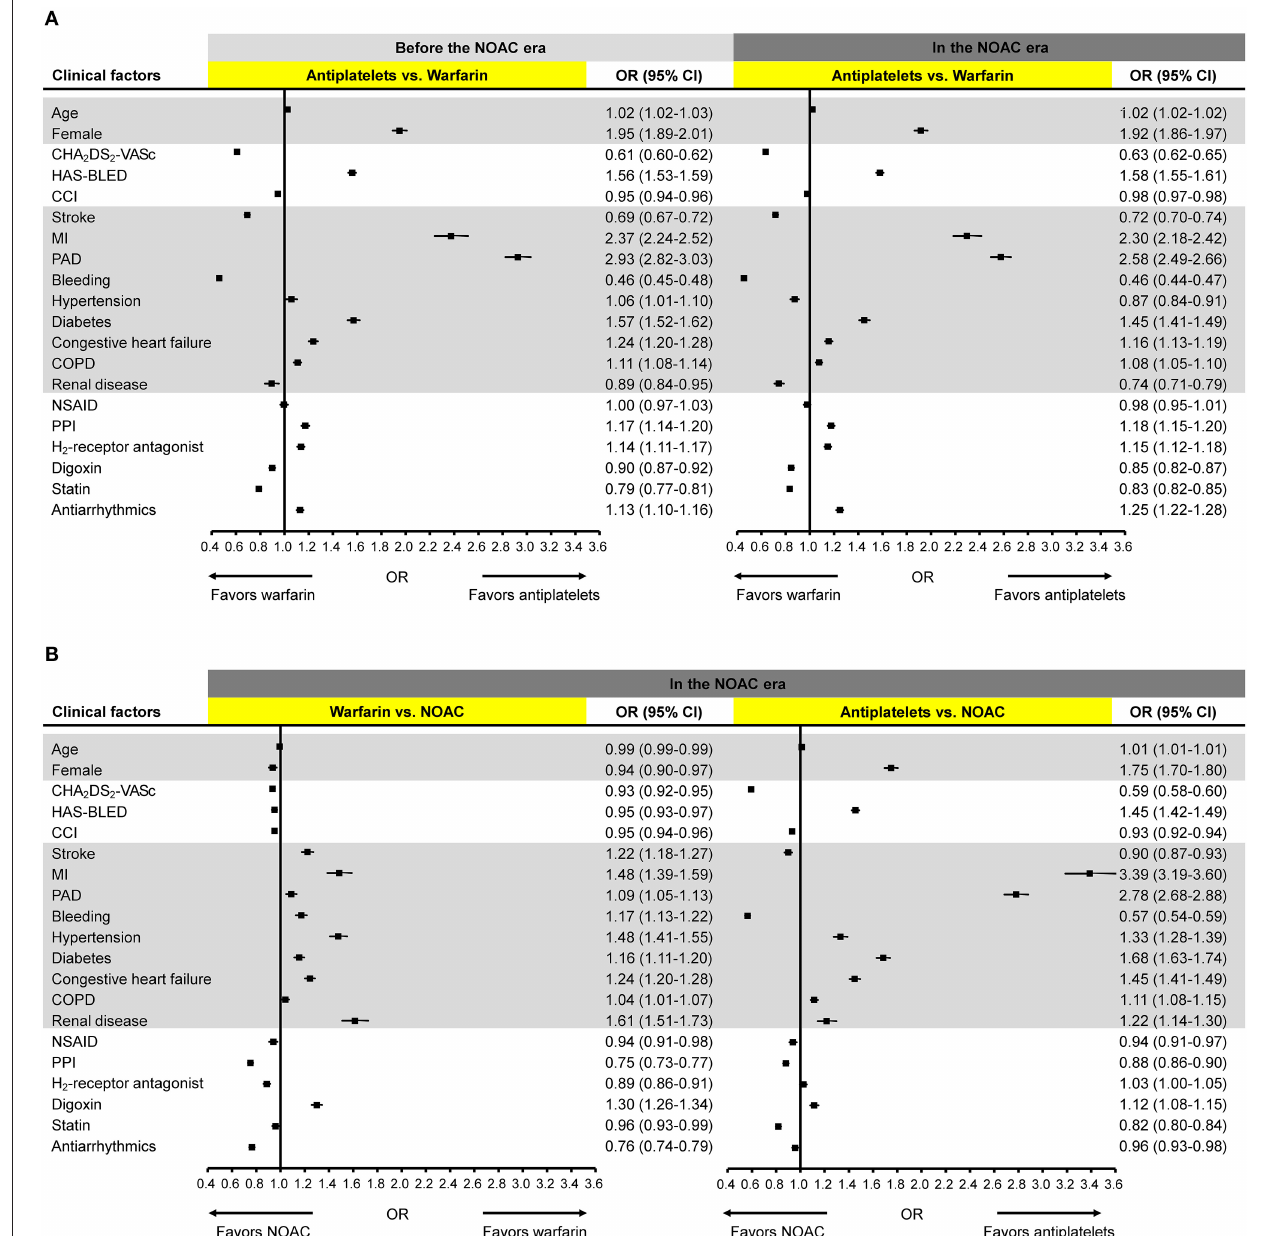
FIGURE 3 | Clinical factors associated with the choice of antithrombotics. Odds ratios for the association of clinical factors with the choice of (A) antiplatelets vs. warfarin before and after the NOAC introduction; (B) warfarin vs. NOAC and antiplatelets vs. NOAC after the NOAC introduction. CCI, Charlson Comorbidity Index; CI, confidence interval; COPD, chronic obstructive pulmonary disease; MI, myocardial infarction; NOAC, non-vitamin K antagonist oral anticoagulants; NSAID, non-steroidal anti-inflammatory drug; OR, odds ratio; PAD, peripheral artery disease; PPI, proton pump